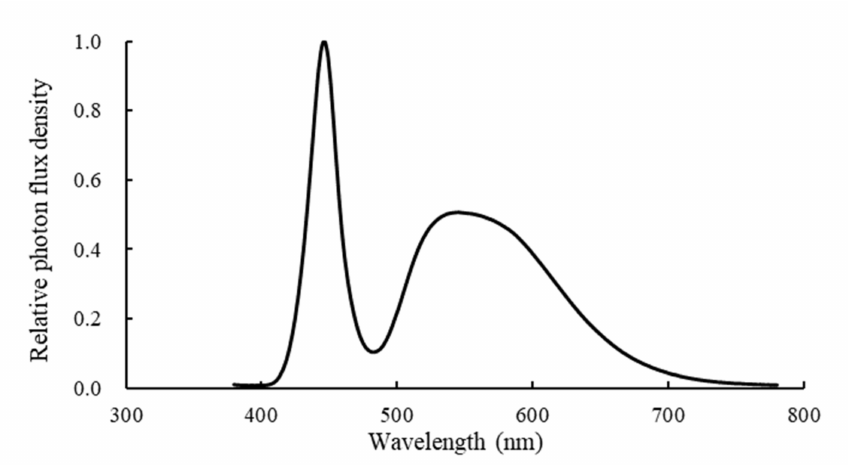
Figure 1. Relative photon flux density of white light emitting-diodes used in the closed transplant production